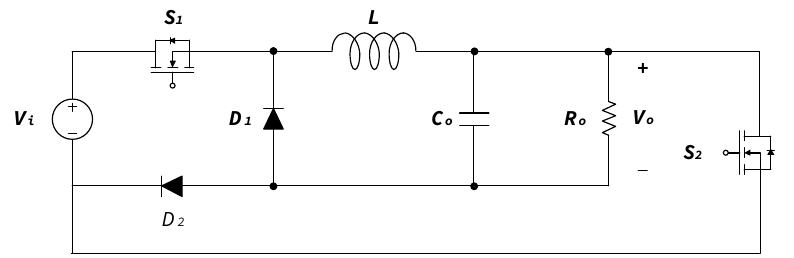
Figure 3. Circuit diagram of the proposed TSBB converter. indicates that the switching operations of S 1 , S 2 , and D 1 are the same as those of the and is always off in the buck-boost topology. Table 4. Switch operation of the proposed TSBB converter.